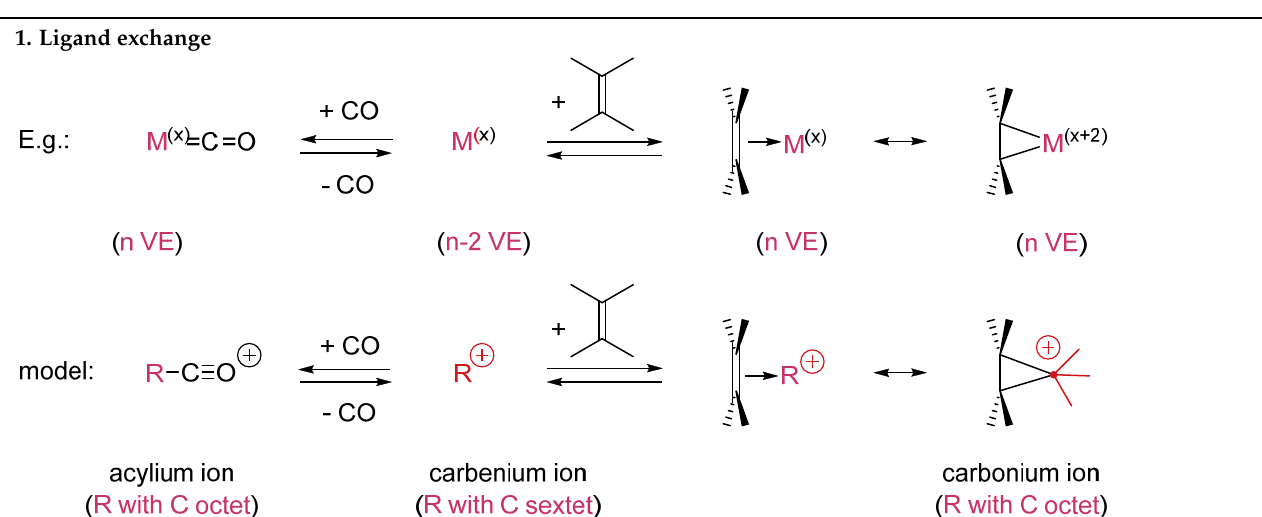
Table 1. Fundamental reactions of transition metal complexes and comparison with organic reactions. Tolman’s rules are applied to define (conventionally) the oxidation number x of the metal, M (VE: number of valence electrons). [M] = M (x) for a metal bearing other ligands eventually, including solvent molecules. Reprinted with permission from Ref. [17]. Copyright 2019